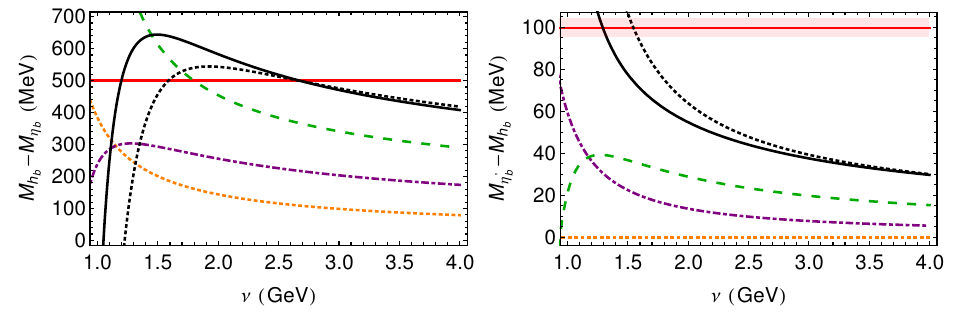
. Left panel: plot of M h (cid:0) M (cid:17) . nl b b